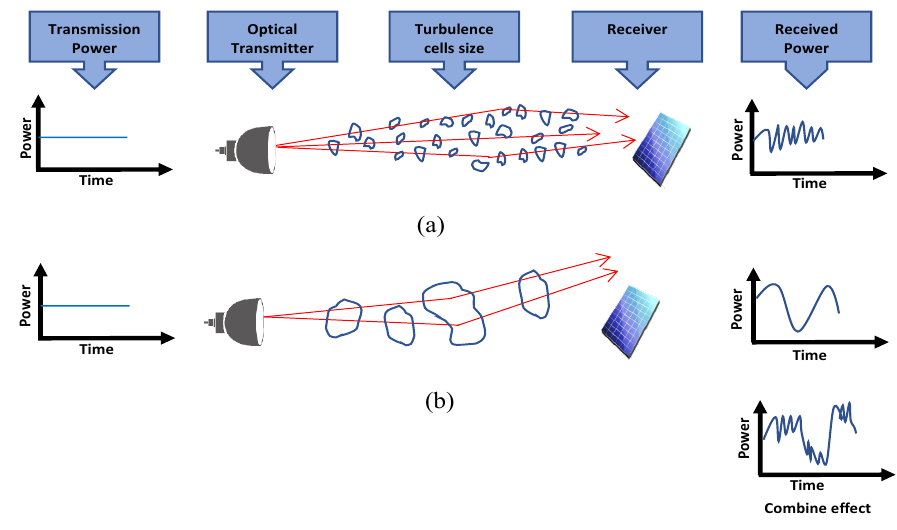
Figure 1. Comparison of Turbulent Cell Size with ( a ) Scintillation and ( b ) Beam